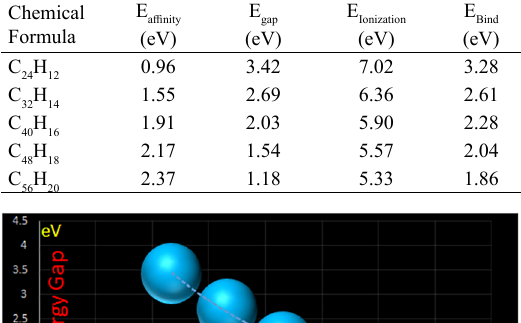
Table 2. Electron Affinity Energy, Energy gap, Ionization Energy and Binding Energy of the first five members of Circumacenes family (1 eV = 1.6 × 10 -19 J ).